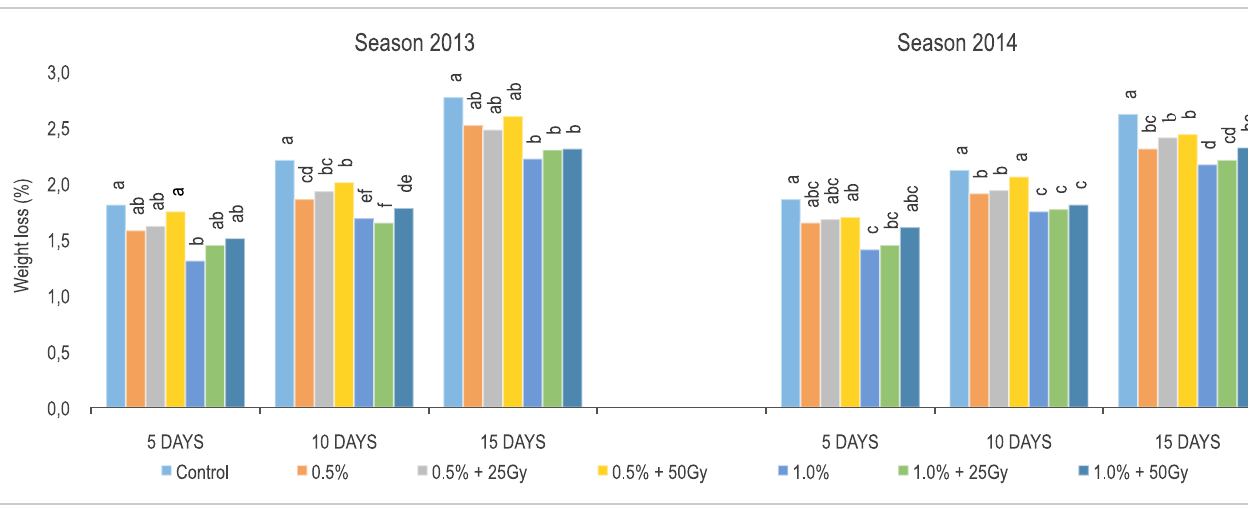
Tab. 1: Effect of irradiated and unirradiated chitosan on arils juice TSS (%) during cold storage.